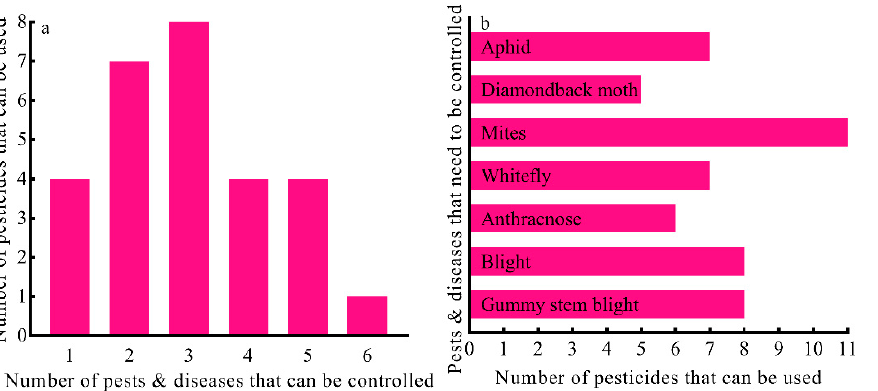
Figure 8. Non-one-to-one relation of pesticides against diseases and pests. ( a ) Broad spectrum of some pesticides. ( b ) There are many pesticides available against one disease or pest.